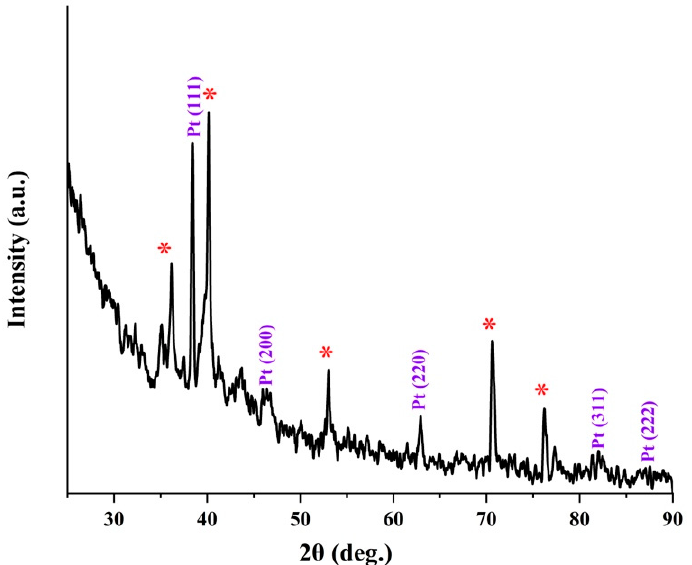
Figure 6. XRD analysis of Pt grown on TiO 2 /Ti mesh. (*) Corresponds to the TiO 2 substrate.